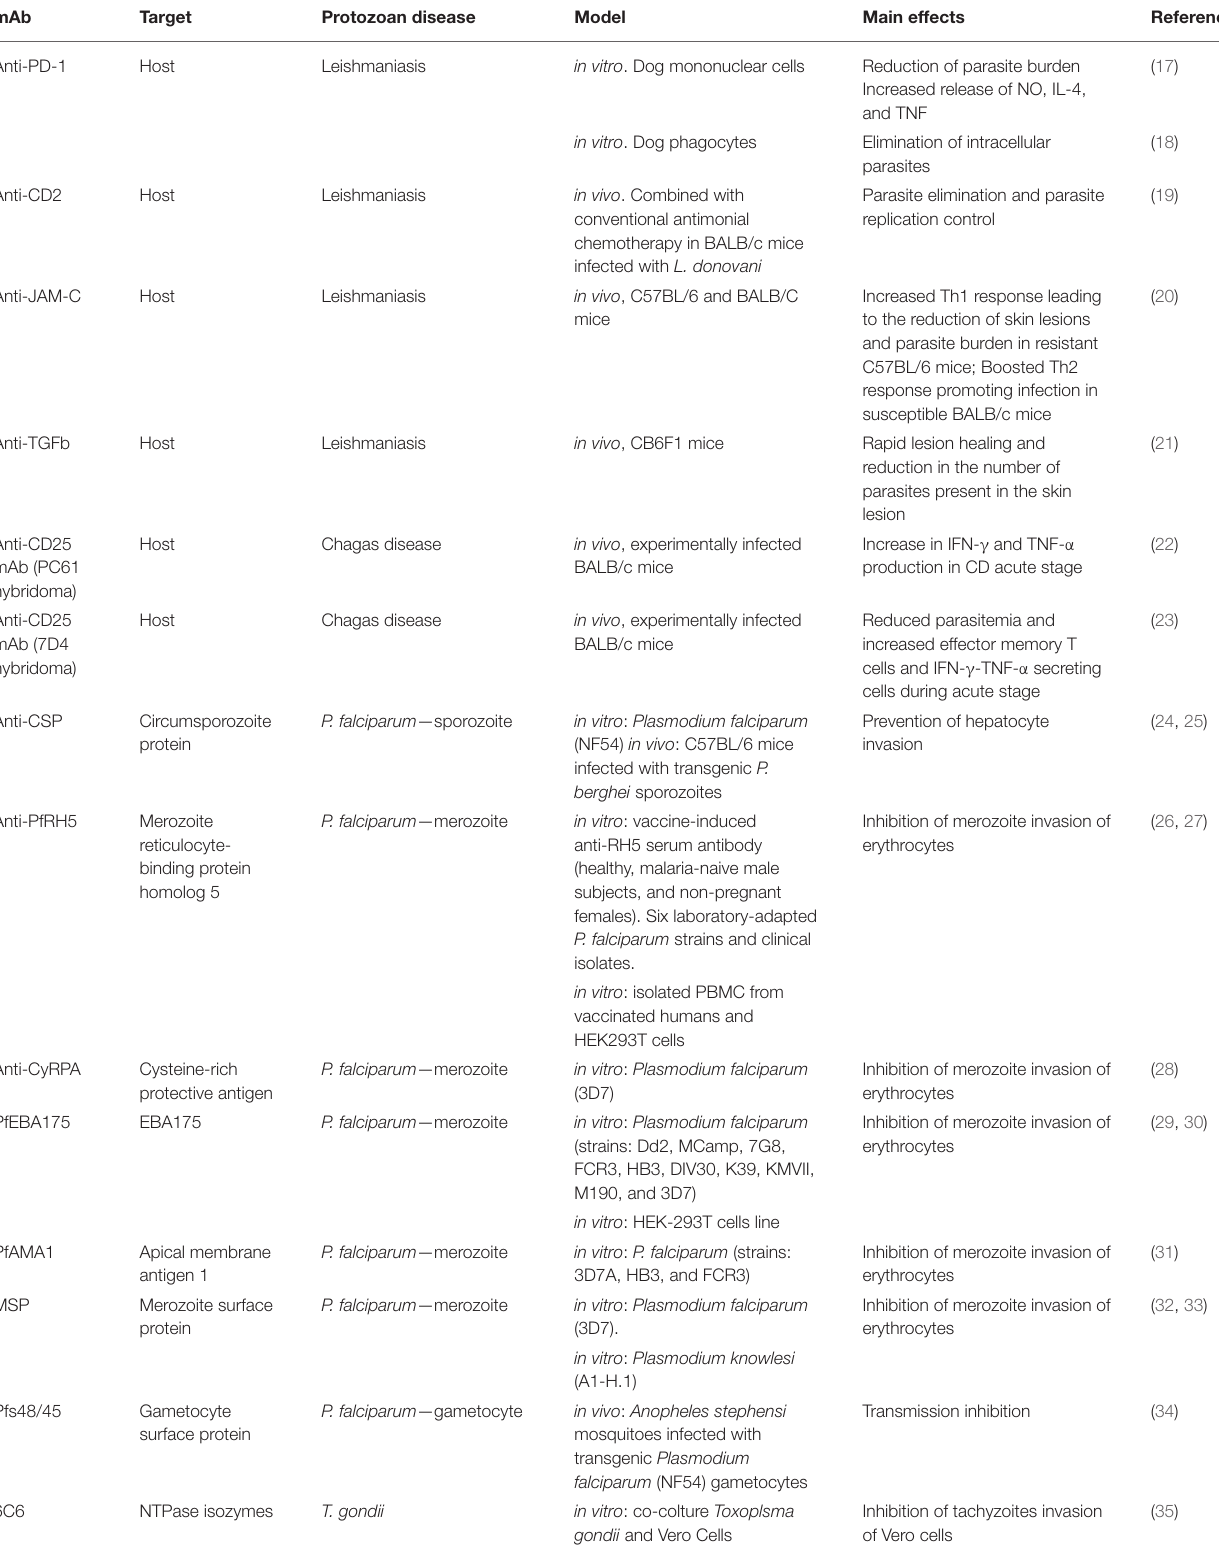
TABLE 1 | mAb evaluated in in vitro and animal models for protozoan diseases treatment.